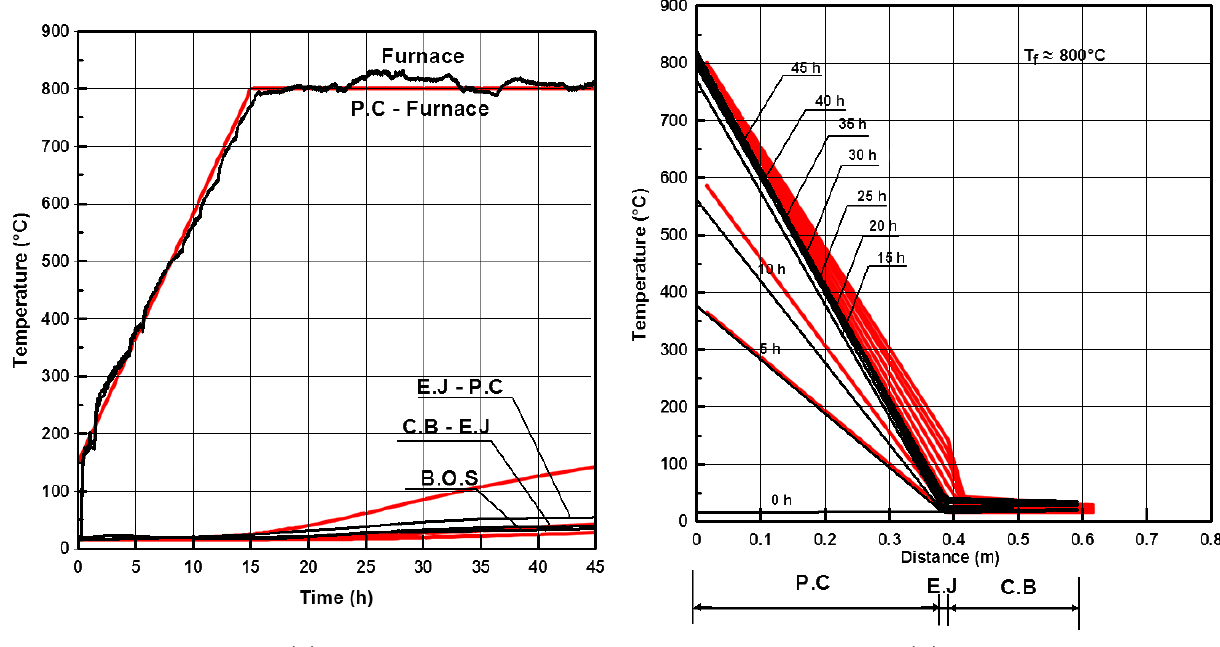
Figure 10. Experimental and simulation results of the TES bin for the half that was not covered with IFB: ( a ) temperature over time and ( b ) transient to steady-state temperature distributions across the layers (black lines represent the experimental data, and red lines represent the simulation